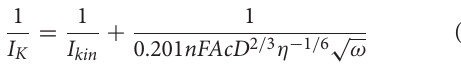
the extrapolation to infinite rotation rate will actually give a zero-ordinate